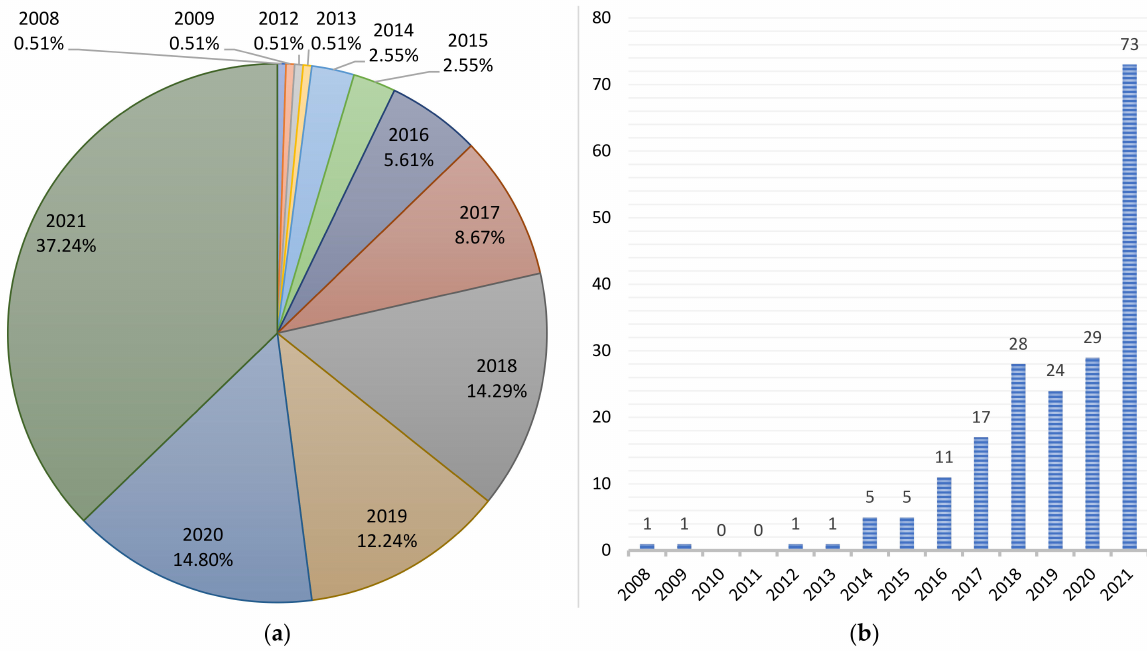
Figure 6. ( a ) Percentage ratio of scientific production by years; ( b ) distribution of scientific information by